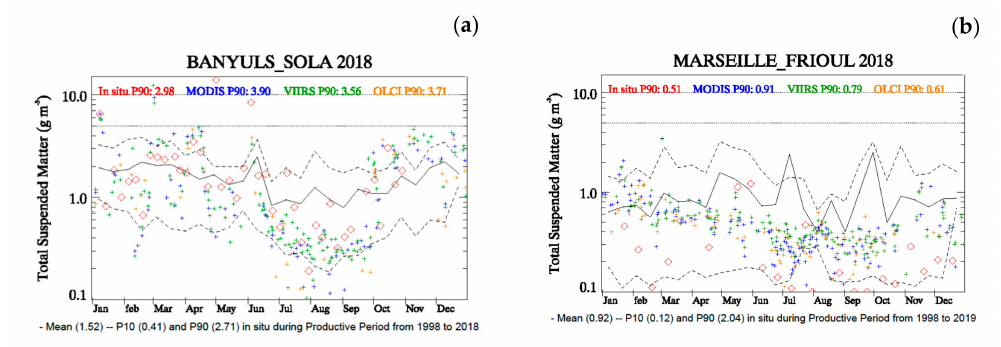
Figure 11. TSM at Banyuls-Sola ( a ) and Marseille-Frioul ( b ) in 2018. In situ and satellite percentiles of year 2018 are indicated in the upper part of the graphs; the in situ historical mean, P10 and P90, calculated over the productive period, are indicated under the time